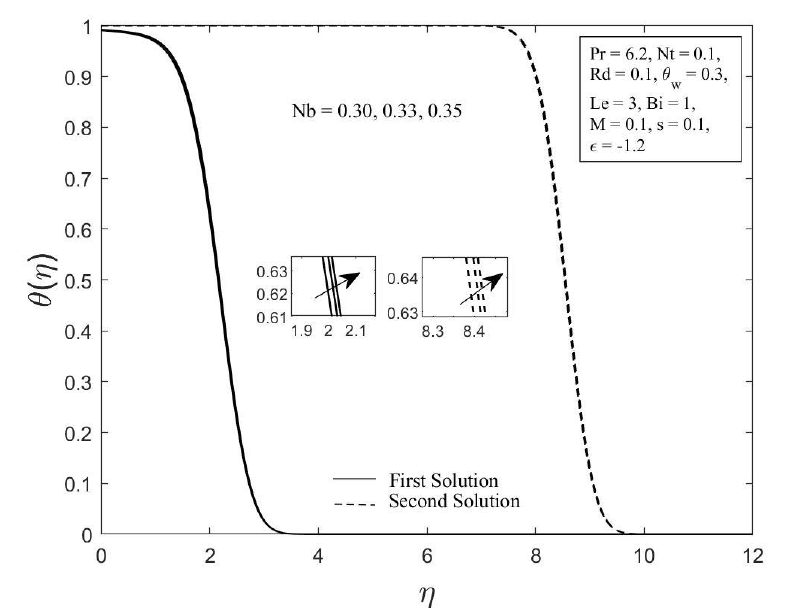
Figure 6. The temperature profile 𝜃(𝜂) for diverse values of 𝑁𝑏 .